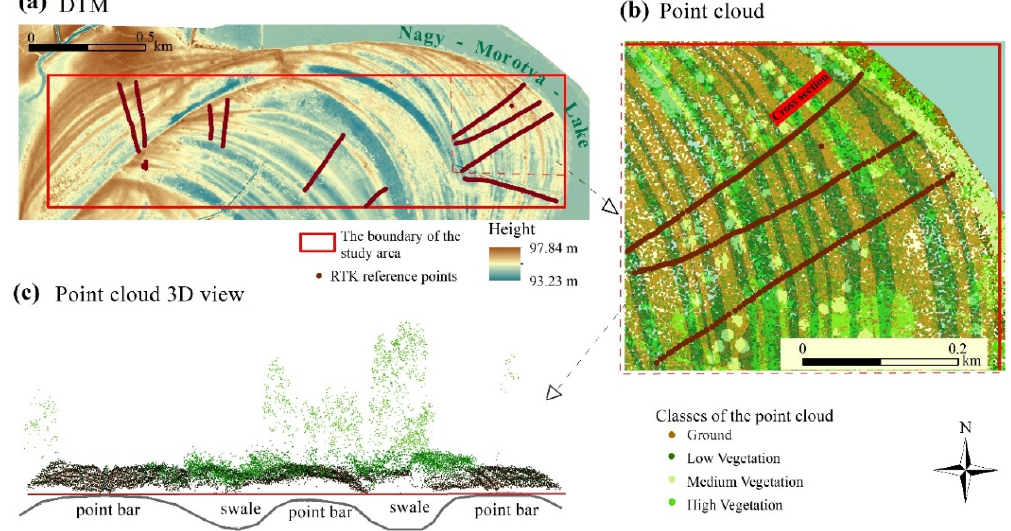
Figure 2. The characteristics of the study area. ( a ) It is characterized by a well-developed point bar and swale series; ( b ) the widths of bars and swales are various; ( c ) the point cloud of the study (exaggeration: 4) reflects back that swales usually have denser vegetation than point bars.